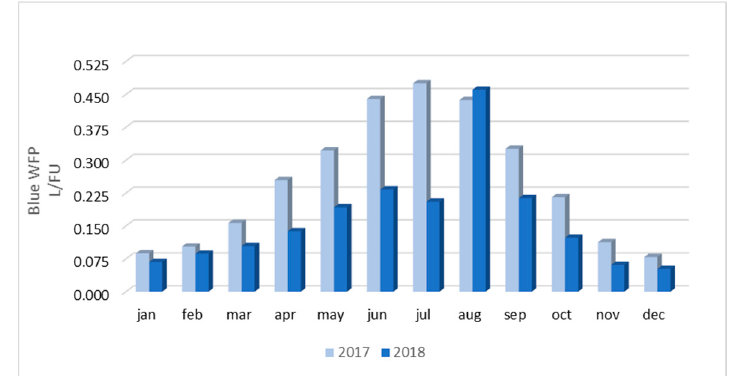
Figure 11. Blue water footprint regarding case study II—Alentejo region, for both years of monitoring.